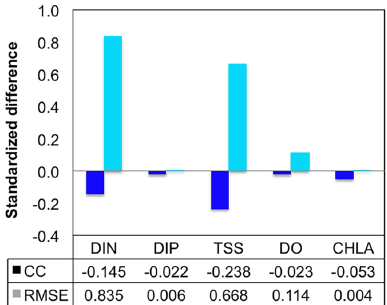
Figure 4. Standardized difference of CC and RMSE in the coarse ‐ grid model compared to the fine ‐ grid model. Standardized score are calculated as follows: Z CC = ( CC coarse − CC fine )/ CC fine , Z RMSE = ( RMSE coasrse − RMSE fine )/ RMSE fine . CC and RMSE denote the correlation coefficient and root mean squared error between the model simulation and the observation, respectively. The raw data of CC and RMSE are shown in Table 3. The five variables are DIN (dissolved inorganic nitrogen, including ammonia, nitrite and nitrate), DIP (dissolved inorganic phosphorus), TSS (total suspended solids), DO (dissolved oxygen) and CHLA (chlorophyll ‐ a).